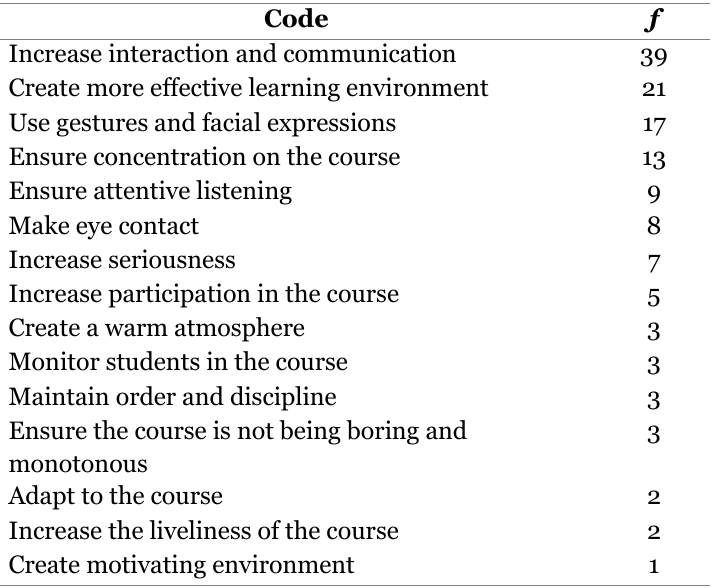
Table 4 Reasons for the Necessity of Turning on